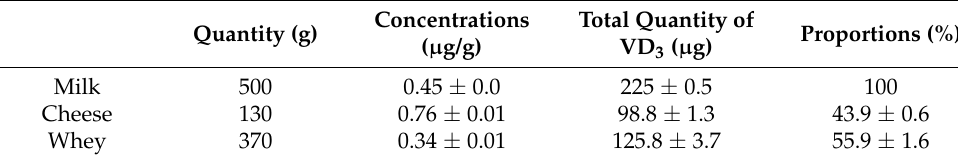
Table 1. Distribution of VD 3 during giuncata